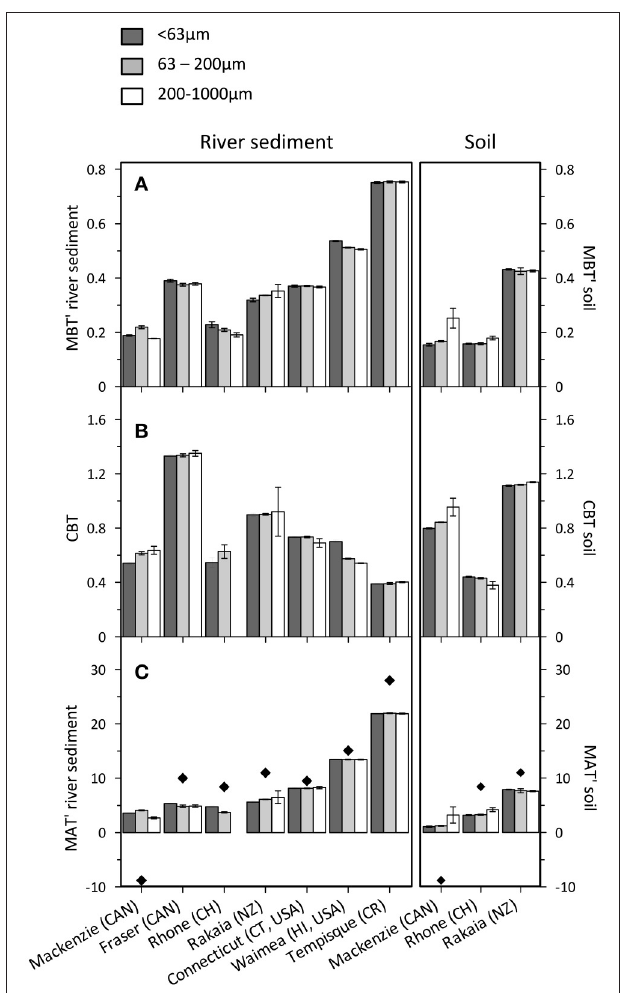
FIGURE 4 | Distributions of brGDGTs in the size fractions of riverbank sediments (left panels) and soils (right panels) expressed in the (A) MBT’ index, (B) CBT index, and (C) MBT’-CBT-based MAT. Diamonds indicate actual MAT at the river mouth. Error bars represent the variation of triplicate sample